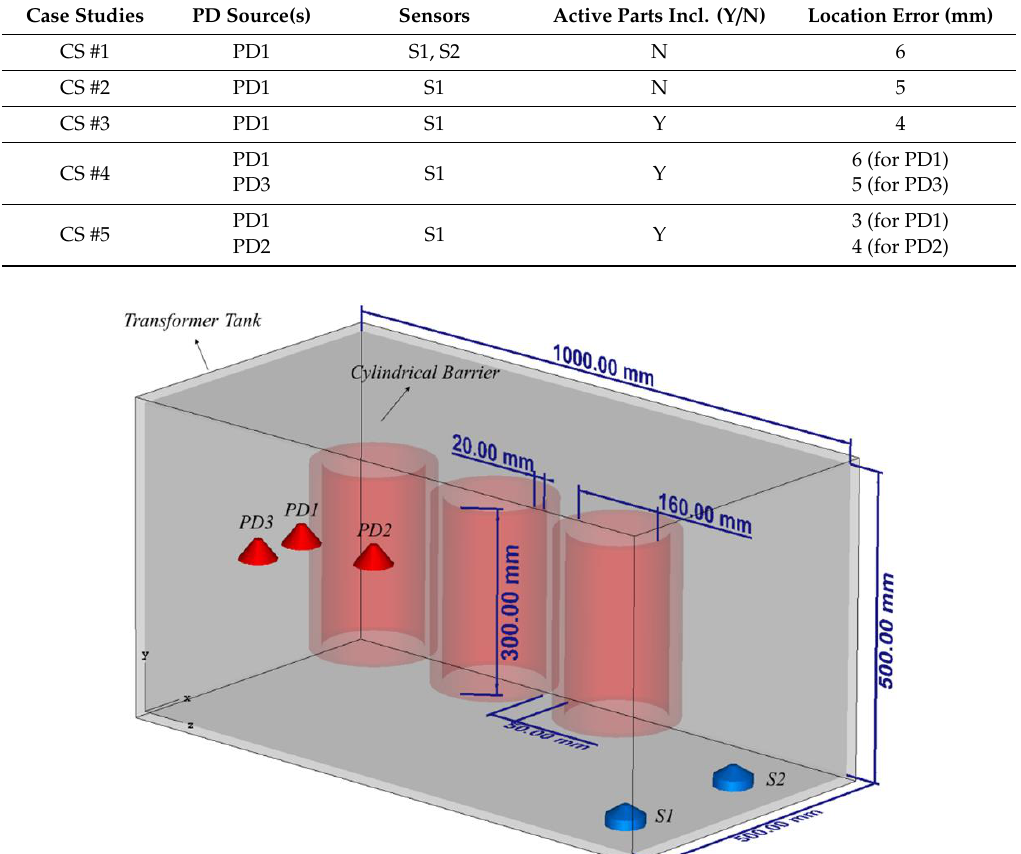
Table 1. List of the performed case studies and the resulting location error.